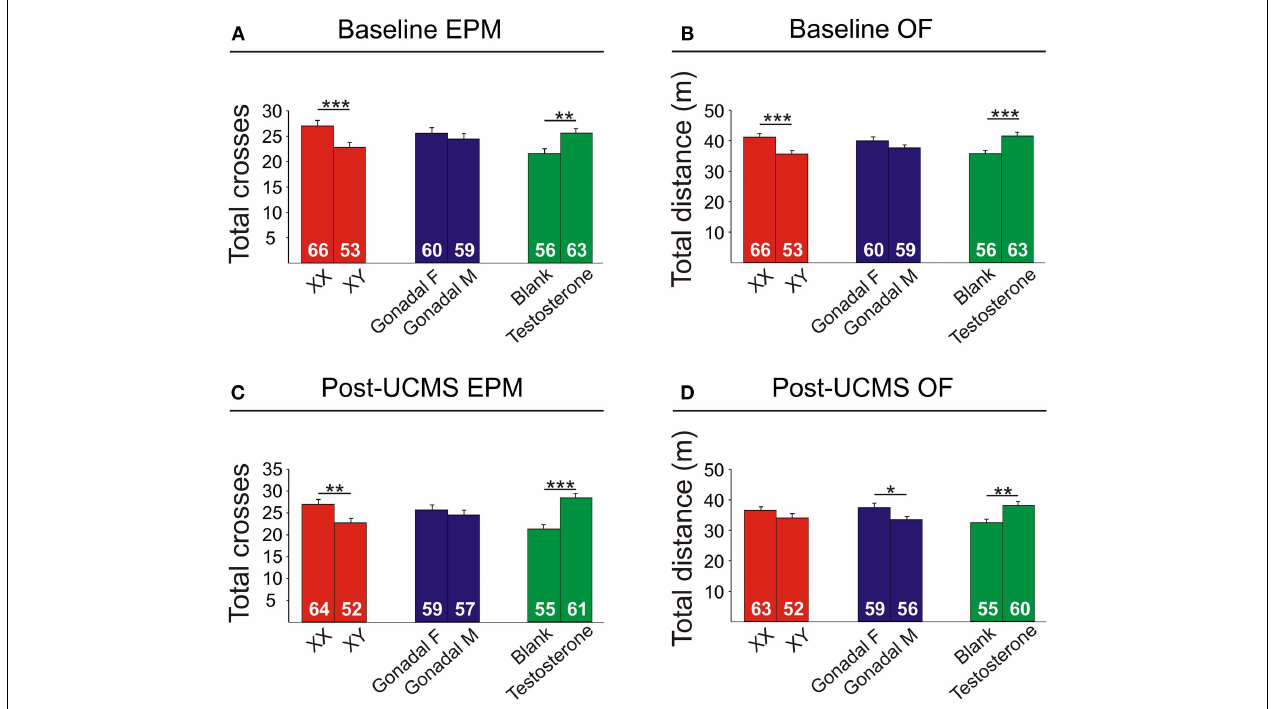
FIGURE 8 | Locomotor activity measures in FCG mice . Elevated plus maze (EPM) results for total crosses at baseline (A) and post-UCMS (C) . Open field (OF) results for total distance at baseline (B) and post-UCMS (D) . Numbers at the base of bars indicate N. Error bars indicate mean ± SEM. *** p < 0.001; ** p < 0.01; * p <